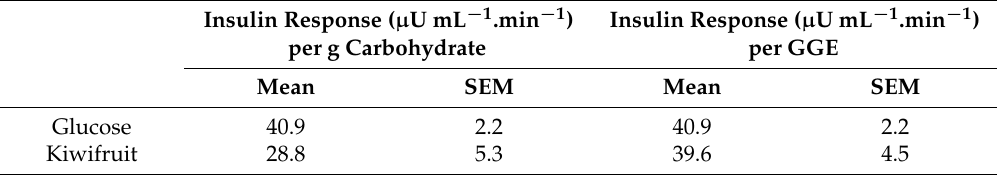
Table 5. Insulin response to glucose and to glycaemic glucose equivalents (GGEs) in